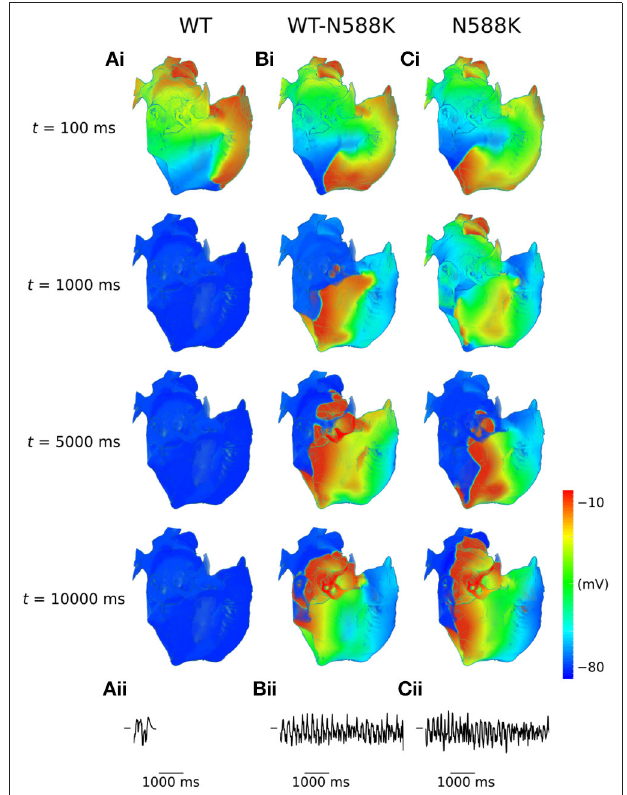
FIGURE 4 | Scroll waves under WT and SQT1 mutation conditions in the 3D anatomical human atria model. (i) Evolution of scroll waves following initiation of re-entry in a clockwise configuration (from a RA posterior wall aspect) at times t = 100ms, t = 1,000ms, t = 5,000ms, and t = 10,000ms under (A) WT, (B) WT-N588K, and (C) N588K conditions, with (ii) corresponding pseudo ECGs taken from the first 5.0s of re-entry simulations.